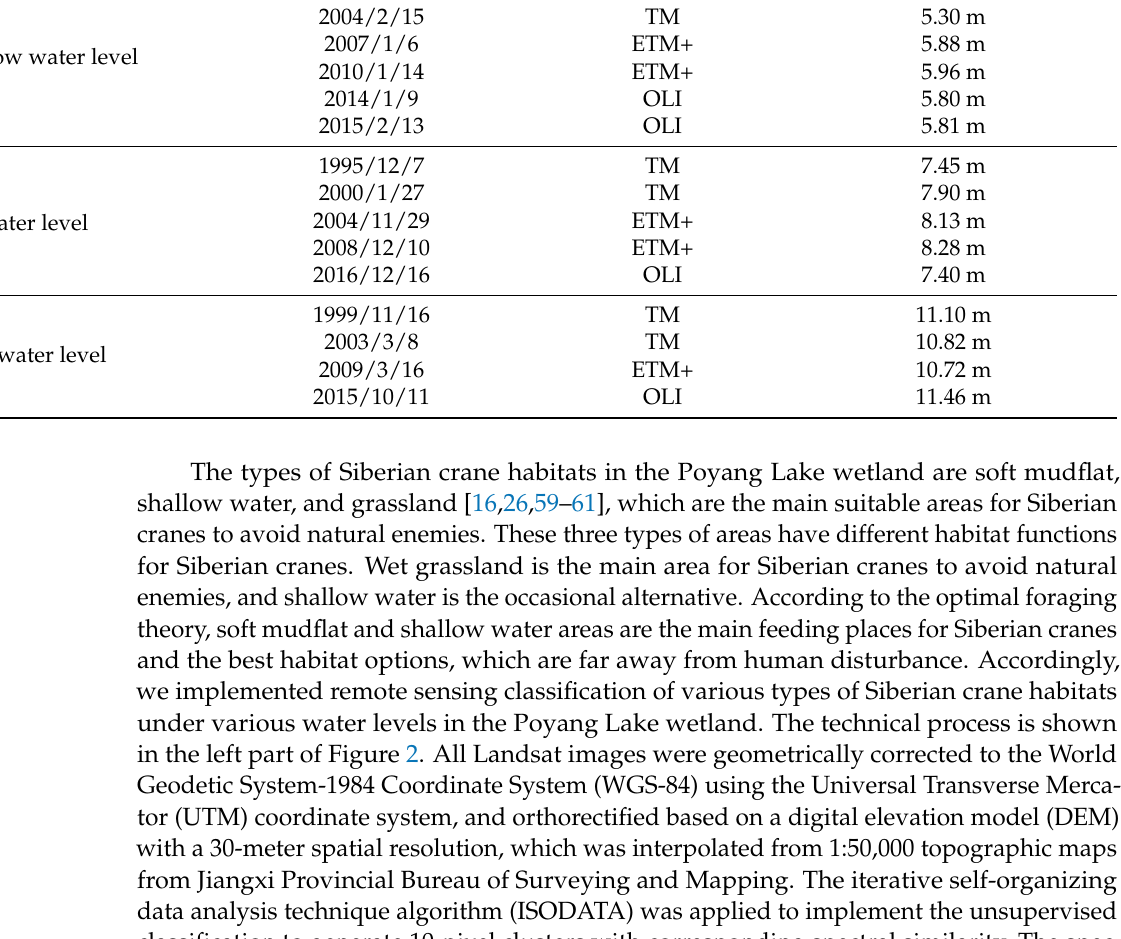
Image Acquired Date Water Level at Xingzi Station Sensor (YYYY/MM/DD) (Yellow Sea Elevation) 1993/1/31